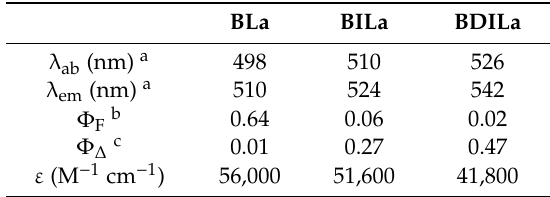
Table 1. Photophysical and parameters of the dyes BLa, BILa and BDILa.